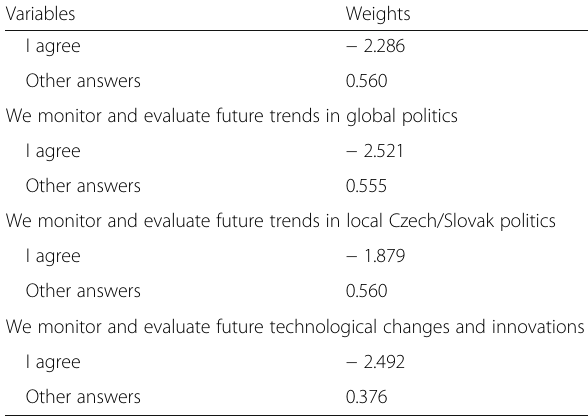
Table 1 Structure of the Foresight Orientation Ratio (FOR) Variables Weights